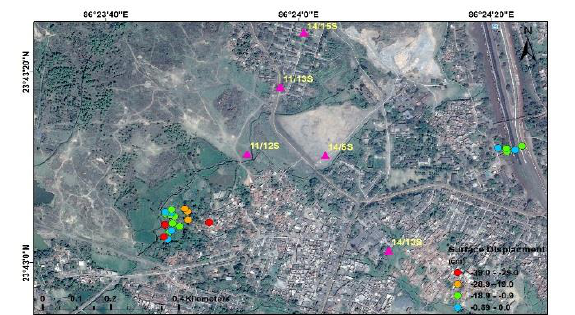
Figure 2. Surface Displacement map obtained using PS-InSAR Technique, Levelling site are marked with pink triangle showing corresponding seam number